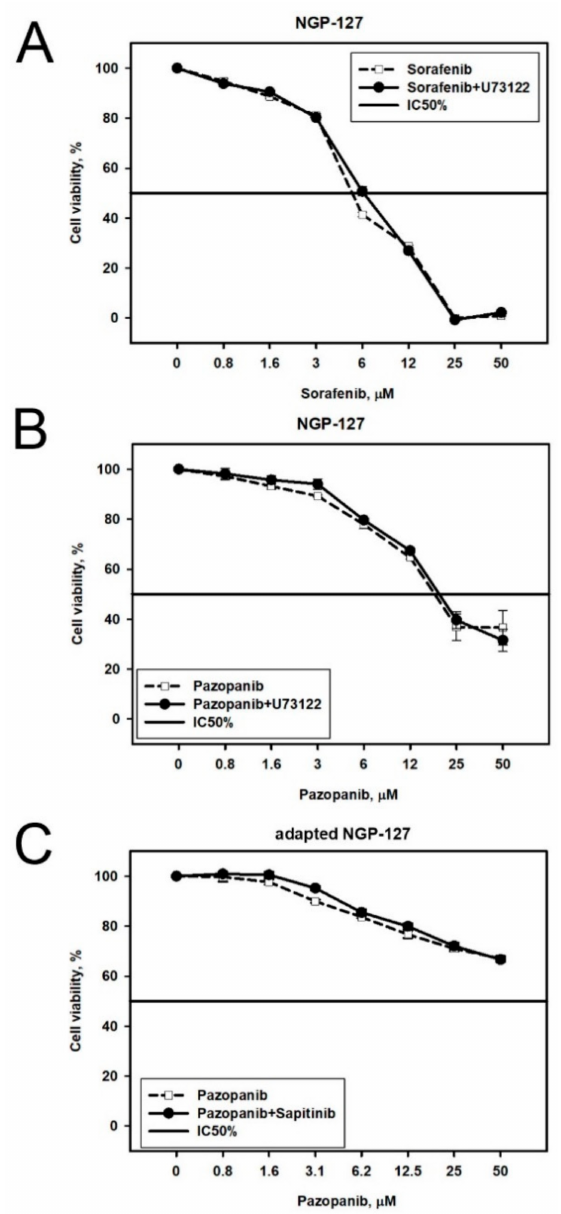
Figure 7. Viability of NGP-127 cells treated with different combinations of target drugs: ( A ) Sorafenib with Phospholipase C inhibitor U73122; ( B ) Pazopanib with Phospholipase C inhibitor U73122; and ( C ) NGP-127 cell lines adapted to Pazopanib and treated with (i) combination of Pazopanib and EGFR inhibitor Sapitinib or (ii) Pazopanib alone. Dashed line corresponds to single drug, solid